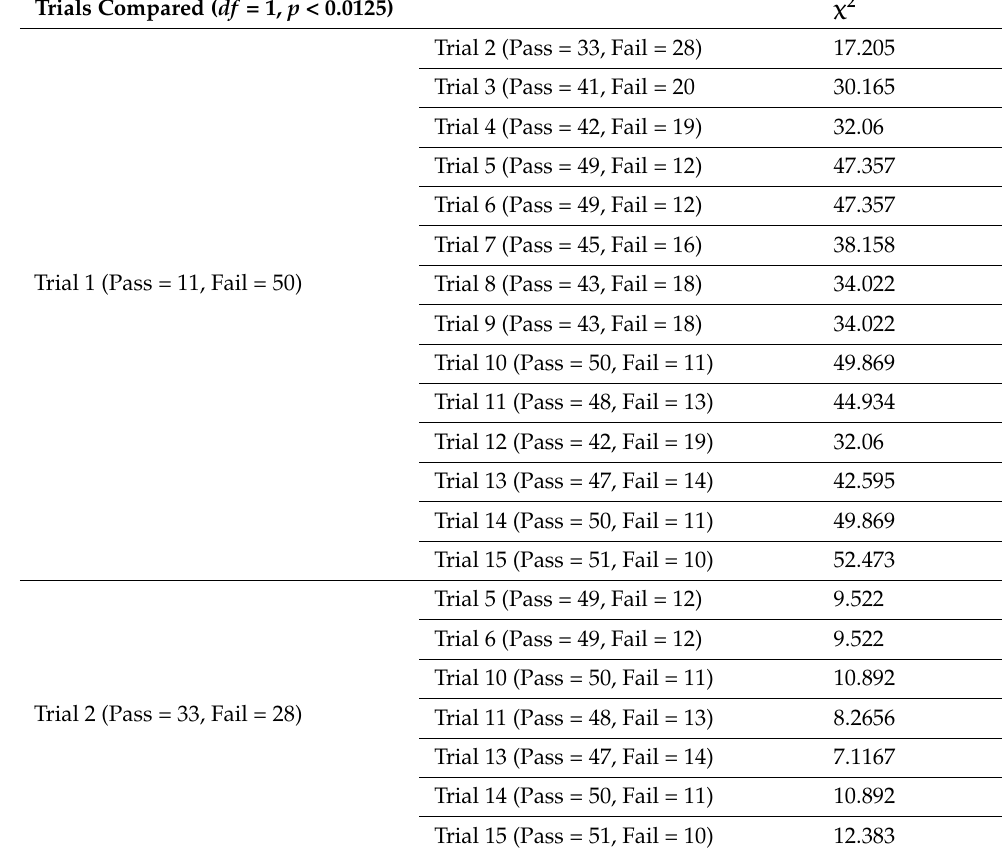
Table 3. Significant differences in the number of participants to pass and fail between